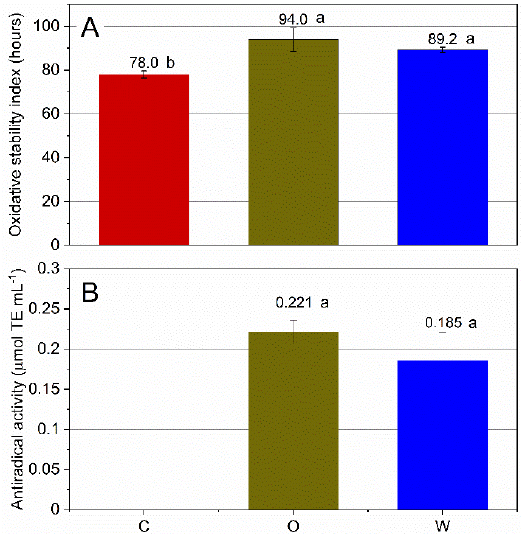
Figure 1. Oxidative stability ( A ) and antiradical activity ( B ) of O/W emulsions added with OPA. C, control emulsion; O, emulsion with OPA added to the oil phase; W, emulsion with OPA added to the water phase. Mean values ± standard deviation ( n = 3). A Tukey’s HSD test for multiple comparisons was carried out, different small letters (a,b) mean a significant difference at p < 0.05.